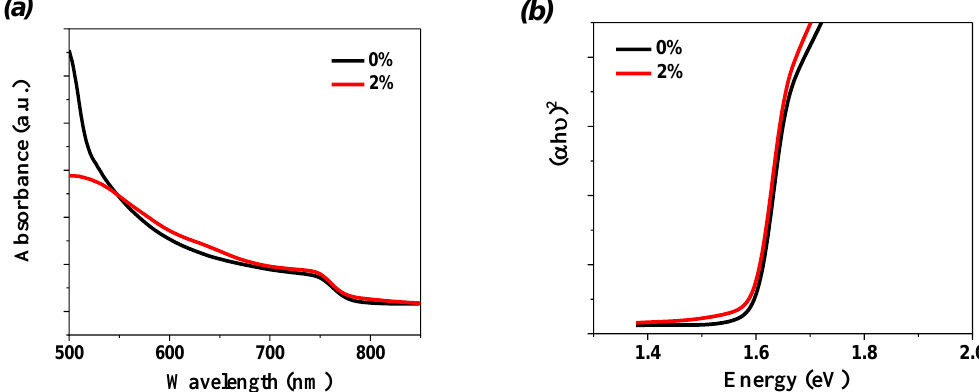
Figure 2: (a) UV-vis absorption spectra, (b) Tauc plots of perovskite films formed on 0% and 4% rGO/Bi